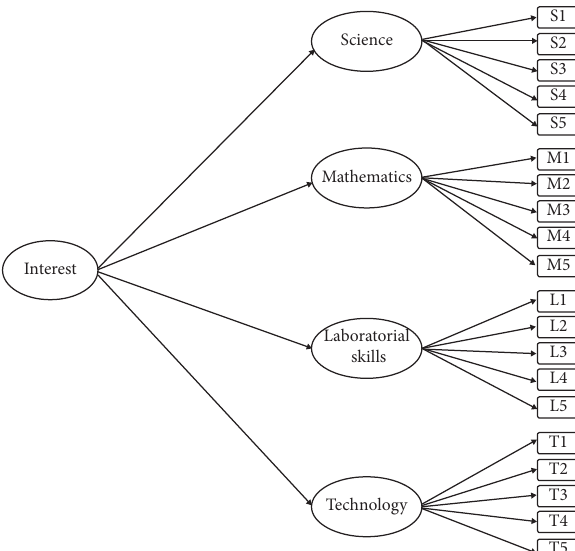
Figure 1: The conceptual framework. Table 1: The assessing interest in the stem content